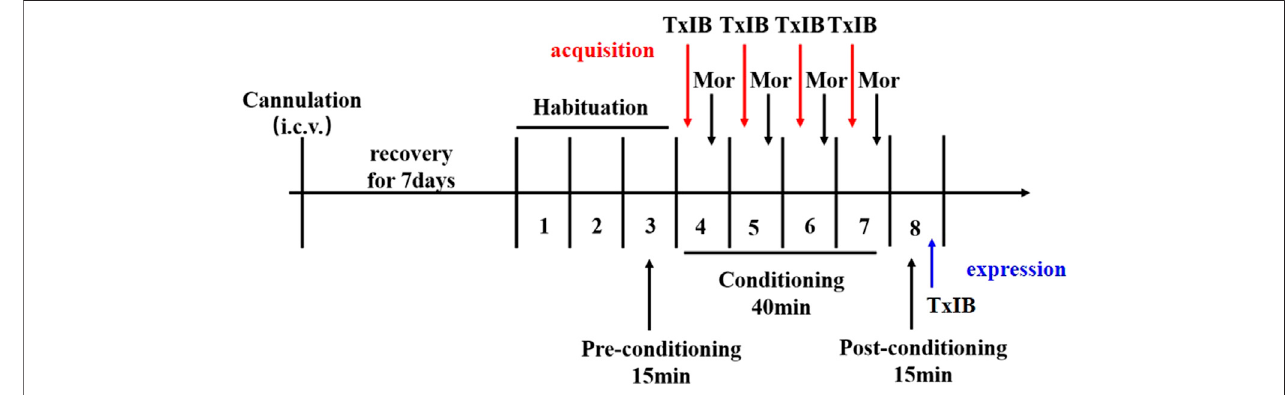
FIGURE 1 | Schematic diagram of the experiment of morphine-induced CPP.